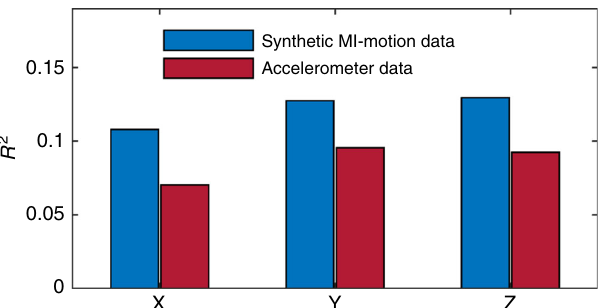
Fig. 3 Average R 2 between XYZ of each target point and data of its corresponding accelerometer and magnetic induction (MI) transceiver.